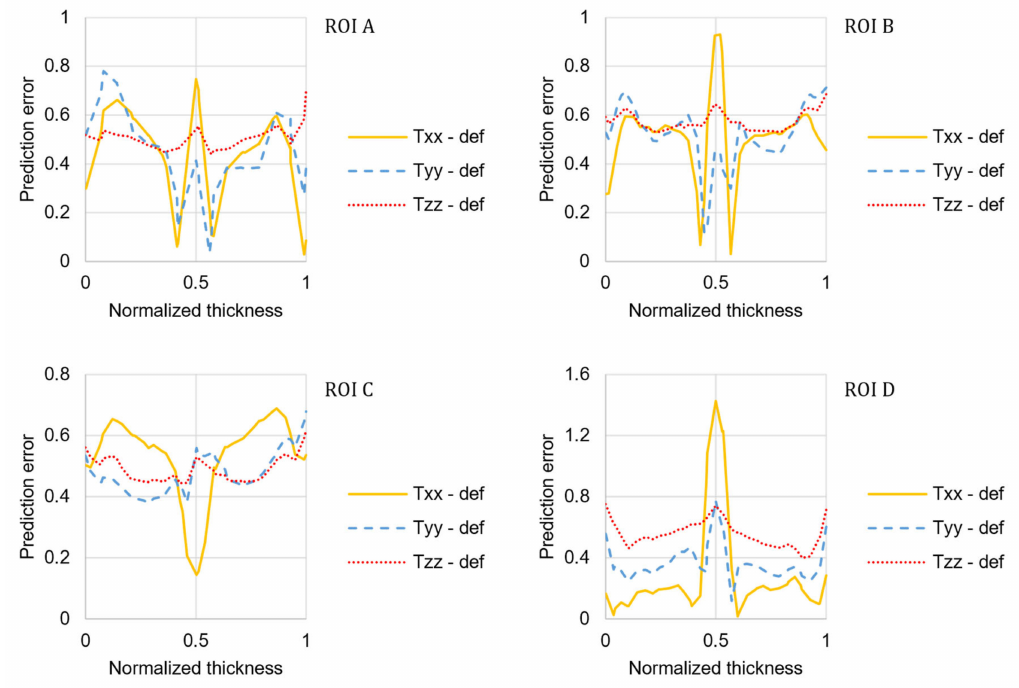
Figure 5. Predictions error distribution obtained with the default coefficients of the RSC model. The application of the proposed optimization algorithm allowed the identification of the optimal values for the RSC model coefficient: C I = 0.0138 and κ = 0.2056. Figure 6 shows the results of the ANN training for the ROI A. The numerical simulation results are reported in the x -axis, and the output calculated by the ANN is on the y -axis.